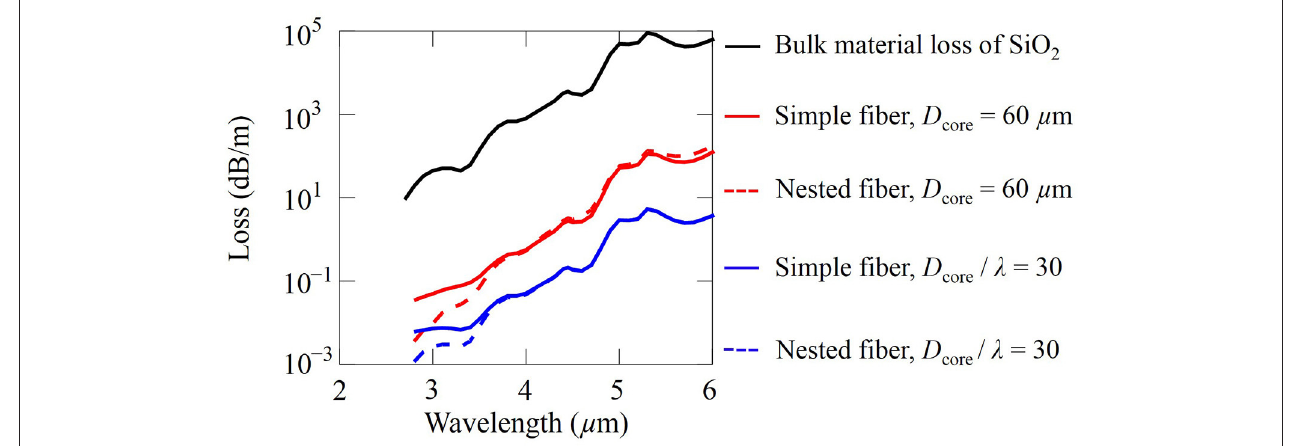
FIGURE 8 | Fiber loss of simple and nested negative curvature fibers made with silica glass.